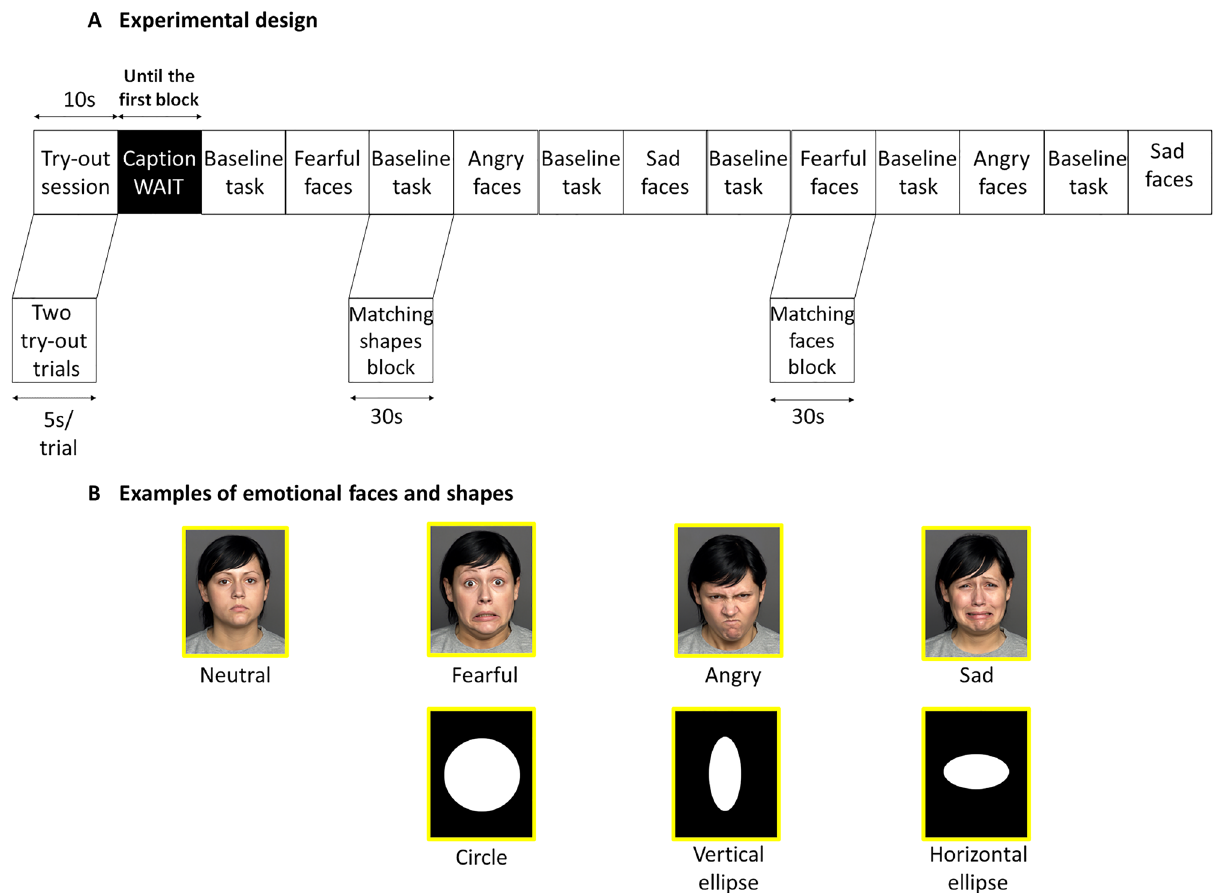
Figure 2. Schematic design of the Facial Emotion Recognition Paradigm 36 and examples of emotional faces from FACES database 43 and shapes. ( A ) : The figure shows that the experiment started with a try-out session in which participants solved one matching face and one matching shapes try-out trial. This was followed by task sessions (12 blocks) that were presented successively (first a baseline block which was always followed by a matching emotion block). Each 30 s block contained six matching trials and subjects were instructed to choose one of the two test faces presented at the bottom (left or right) that was identical to the target image (centre top position). Within each trial, the corresponding stimuli sets stayed on the screen for the entire 5 s, even after the participant made a choice. In all emotion block, the same target emotional expression was presented for six times across the trials. ( B ) : Examples of presented emotional faces with four different expressions (neutral, fearful, angry and sad) and geometric shapes (circle, vertical and horizontal